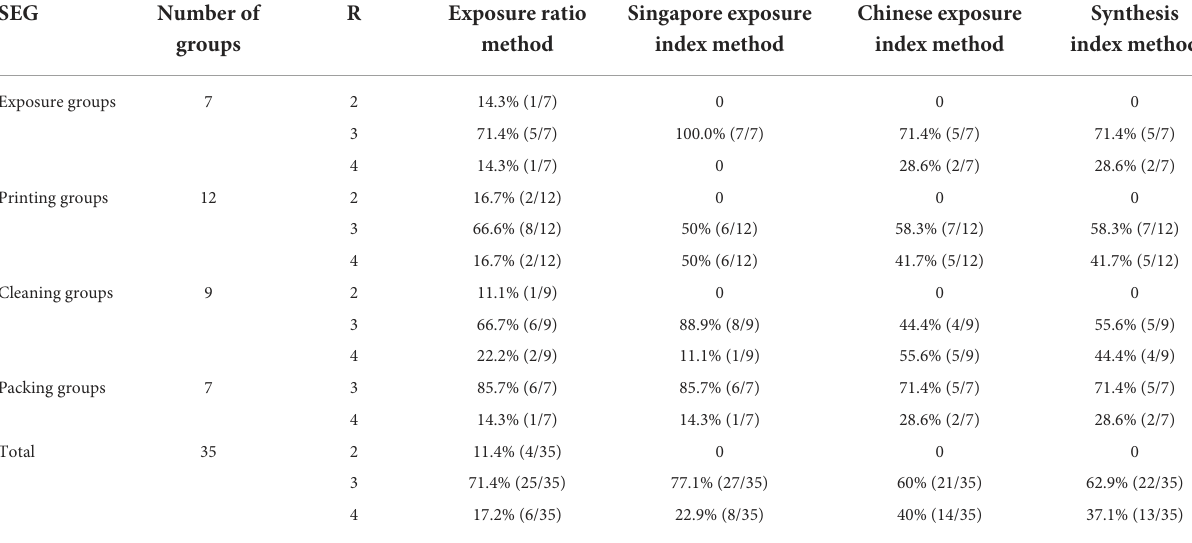
TABLE 3 Evaluation results of semi-quantitative risk assessment models of n-Hexane.